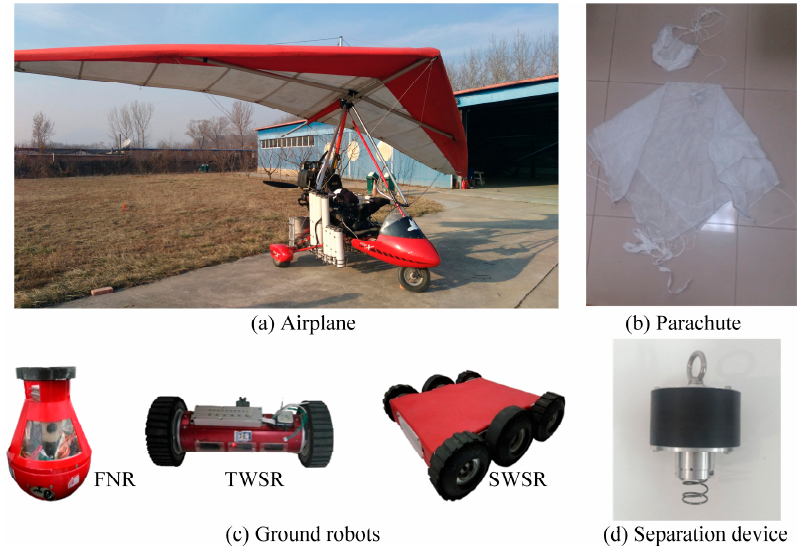
Figure 9. Experimental platform of MSADM.